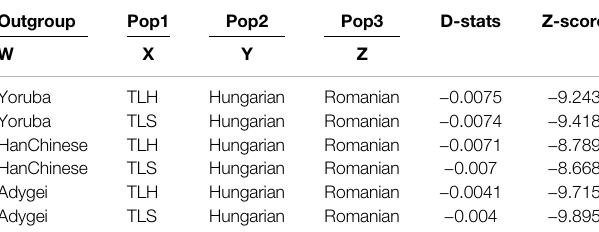
TABLE 1 | 4-population test